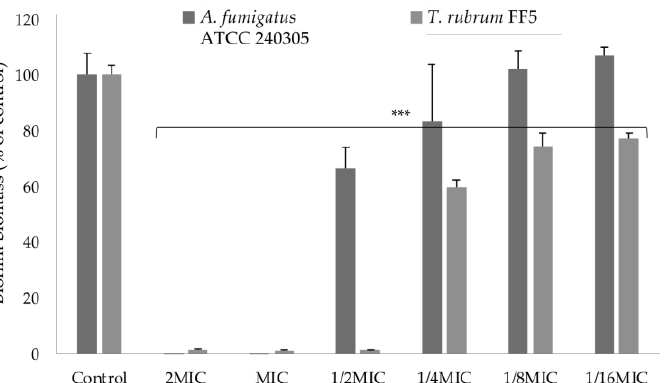
Figure 3. Percentage of biofilm formation by two Candida albicans strains (ATCC 10231 and H37) with different concentrations of compound 1 . Data are shown as mean ± standard deviation of at least three independent assays. Control included an appropriate concentration of dimethylsulfoxide. MIC: Minimal inhibitory concentration. *** p < 0.001 (one-way ANOVA followed by Dunnett’s test).